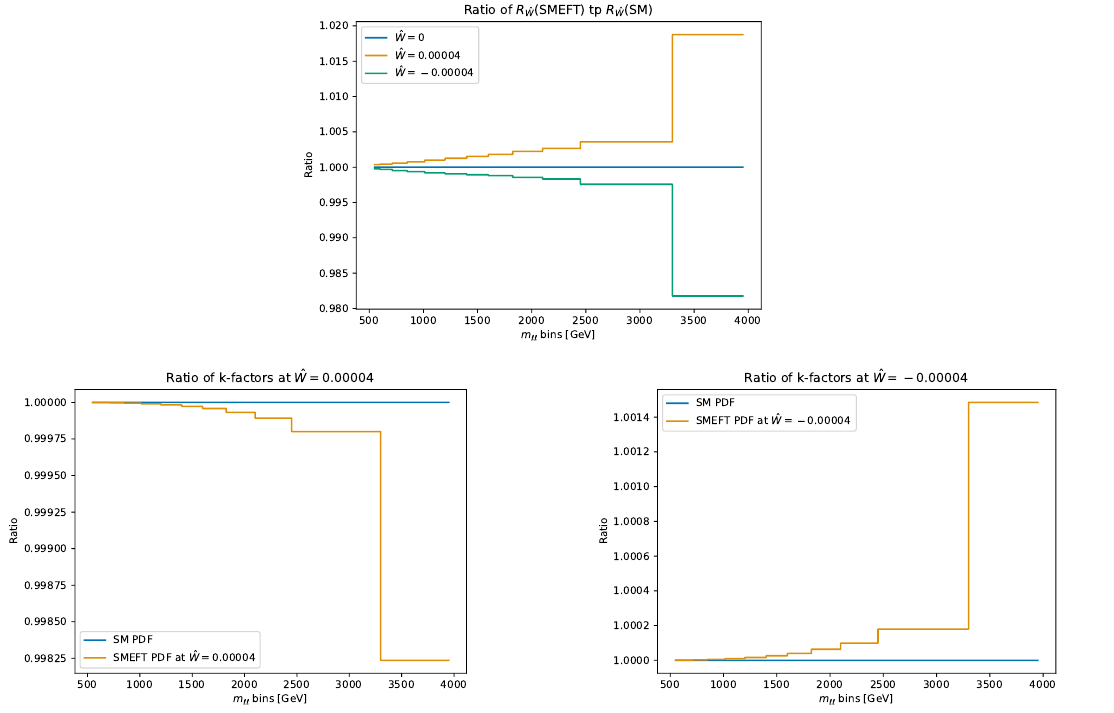
Figure 28 . The impact of the SMEFT PDFs on R W (above) and the SMEFT K-factor K = 1 + ˆ WR W (below) calculated at the Scenario I benchmark points ˆ W = ± 4 · 10 − 5 .